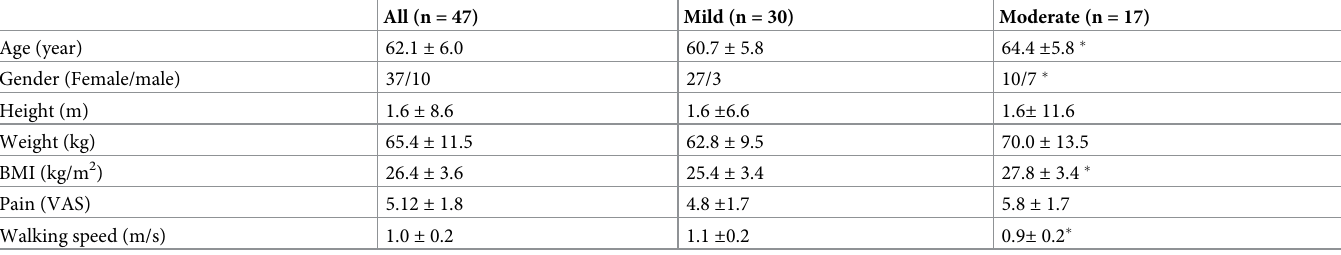
Table 1. Demographic information of